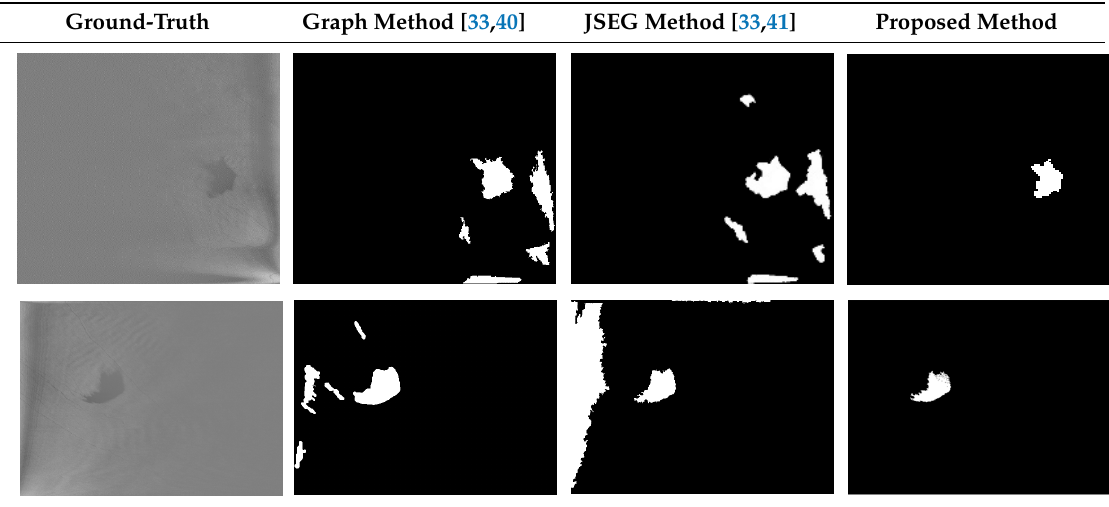
Table 3. Our proposal versus other state-of-the-art methods.